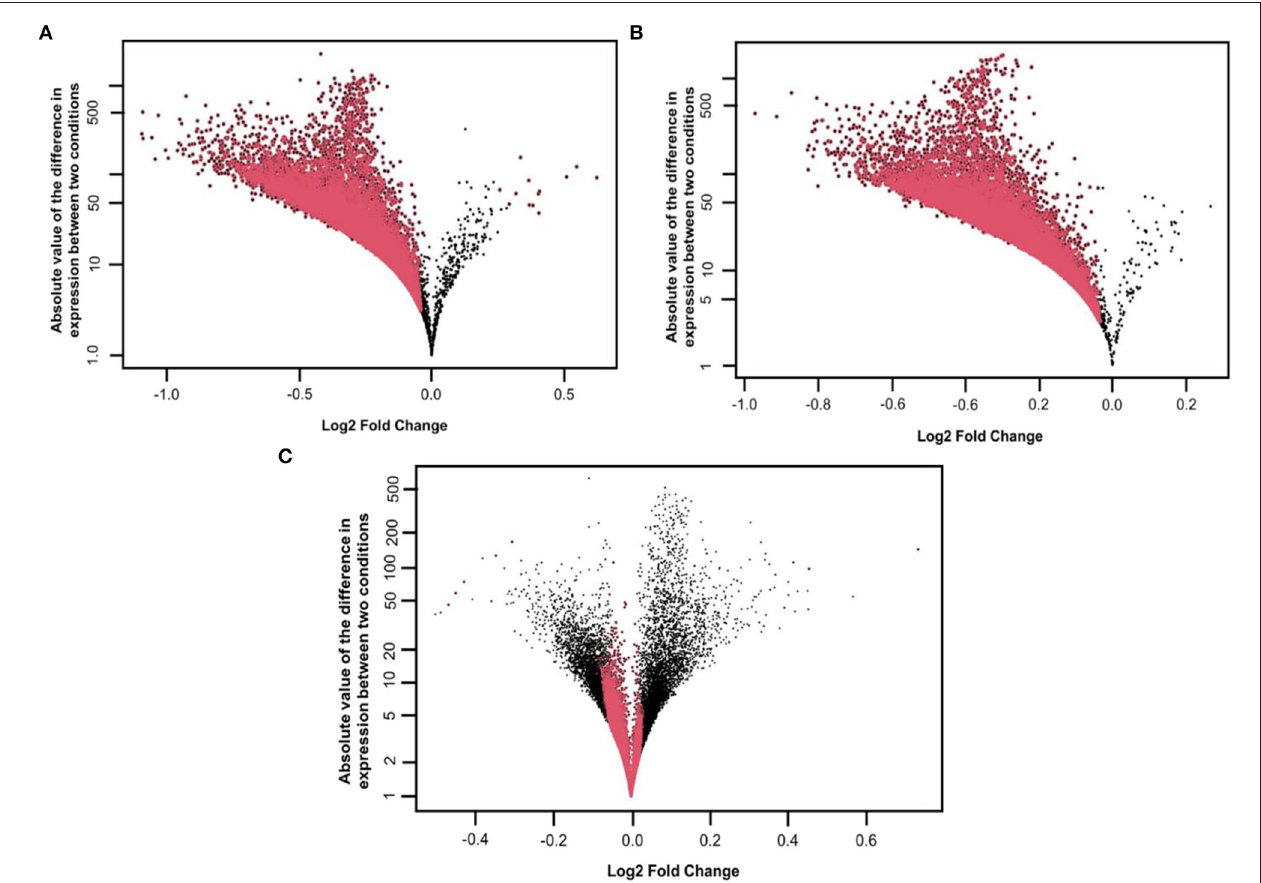
FIGURE 2 | Distribution of M, D values and differentially expressed features on the (A) symAD vs. Control samples (B) symAD vs. AsymAD samples after applying the NOISeqBio function. Differentially expressed genes are shown in red, while M and D values are in Black, and (C) MD plot of AsymAD vs. control samples (GSE118553), showing the distribution of differentially expressed features of genes on a log scale. Red dots correspond to differentially expressed genes with significant probability p -values ( >